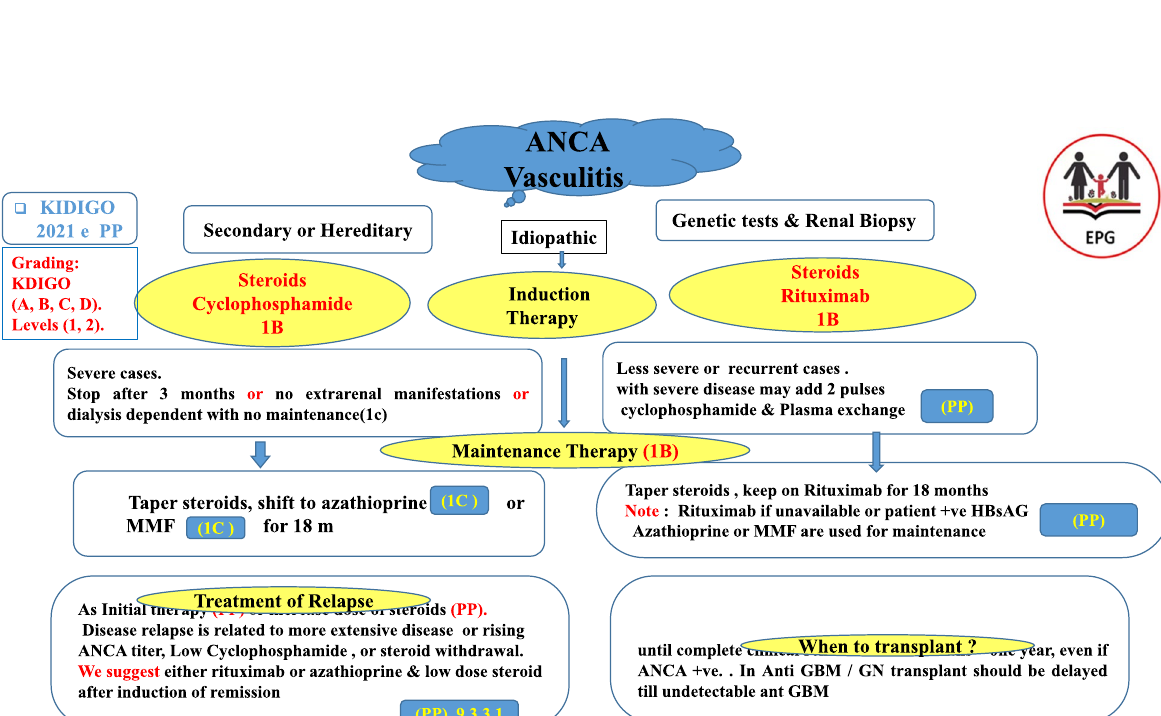
Fig. 3 EPG management of idiopathic ANCAV after excluding secondary and genetic types. R